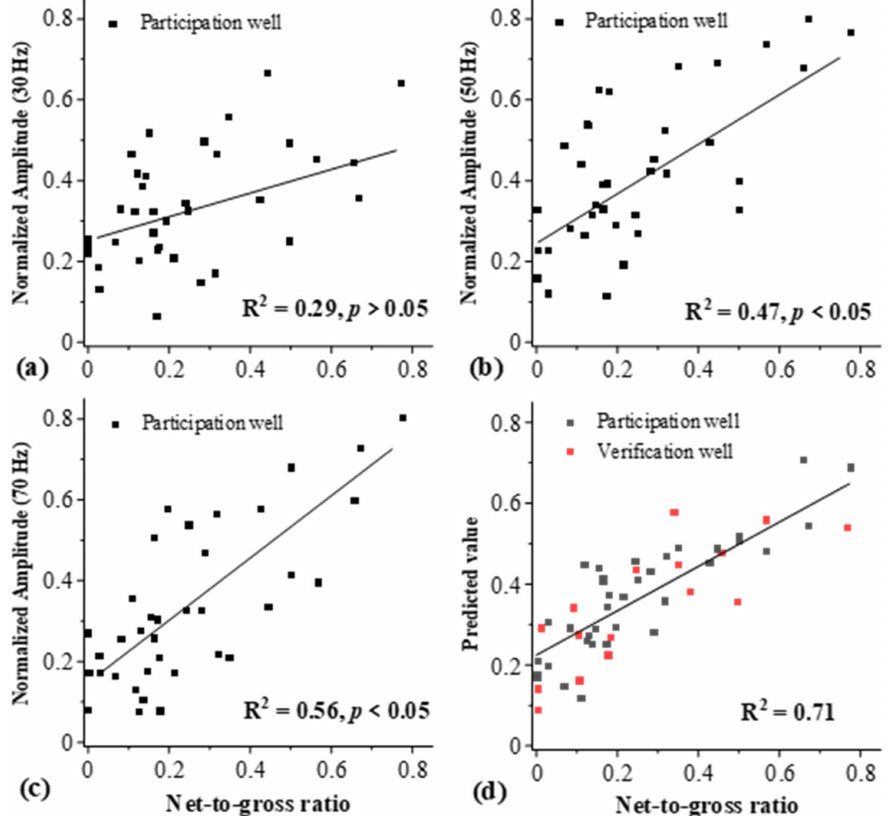
Figure 9. ( a – c ) are the crossplot results of 30 Hz, 50 Hz and 70 Hz normalized amplitude and the net-to-gross ratio of SS2 sequence, respectively. ( d ) Crossplot of the predicted net-to-gross ratio of the SS2 sequence by frequency–division amplitude fusion method vs. the actual value. Note: (1) net-to-gross ratio represents the proportion of sandstones content in a section of the stratum; (2) R 2 was calculated only by participation wells; (3) the frequency–division amplitudes were normalized to eliminate the effect of order of